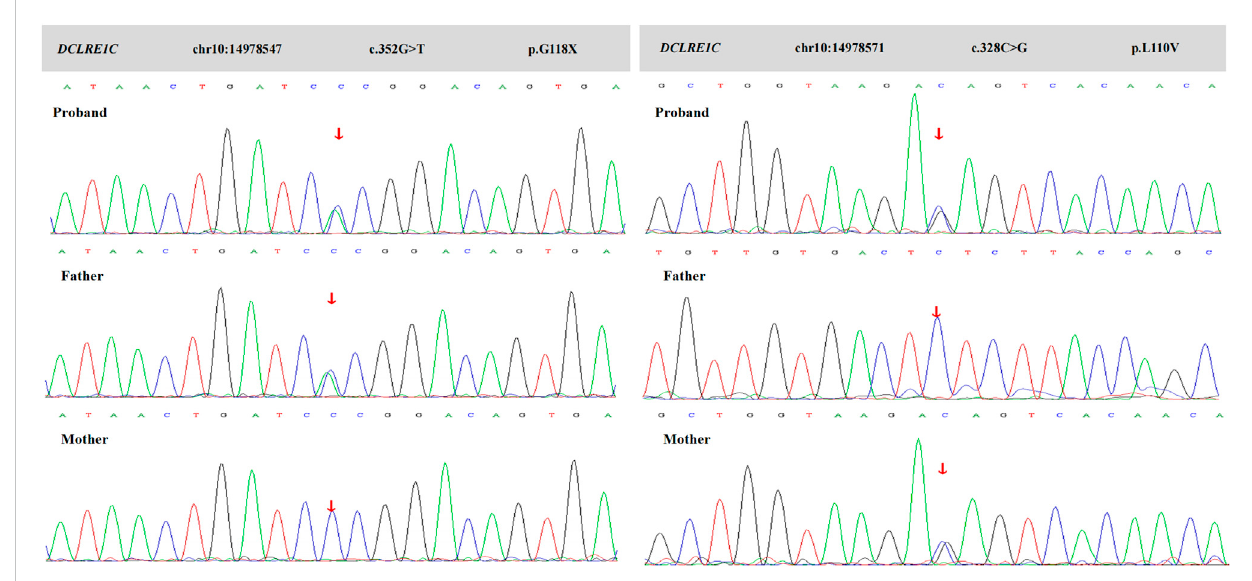
FIGURE 3 Sanger sequence of this family. Chromatograms show that her father is heterozygous for c.352G > T (p.G118X), and her mother is heterozygous for c.328C > G (p.L110V). The proband shows a compound heterozygote of these